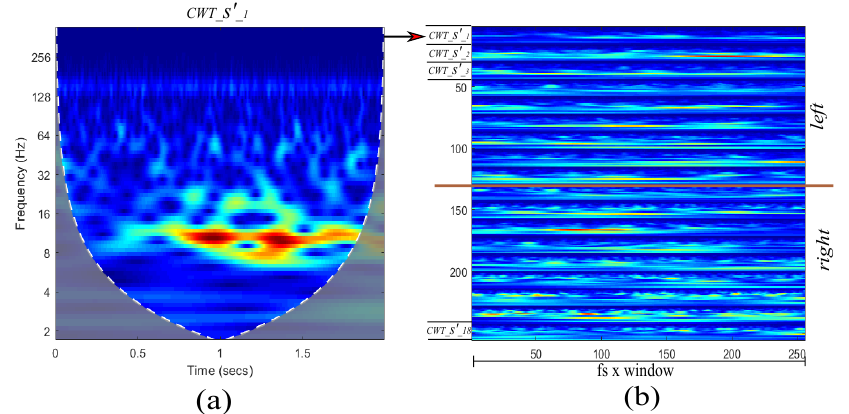
Figure 3. CWT maps for ( a ) one estimated source; ( b ) CWT stacked maps for left and right estimated sources.